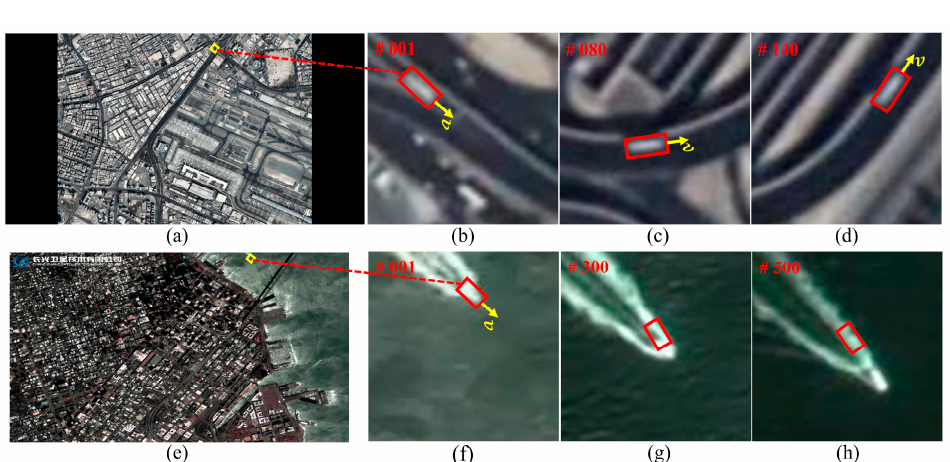
Figure 1. Visualization of object rotation and tracking drift in SVs. The symbol # represents the prefix of the frame number. The current frame is shown in the upper-left corner of each image. The yellow arrow indicates the orientation of the object. ( a ) and ( e ) show the original frames, and the selected objects are enlarged. ( b – d ) show the object rotation. ( f – h ) show the tracking drift due to the complex background and low contrast of the ship and wake.